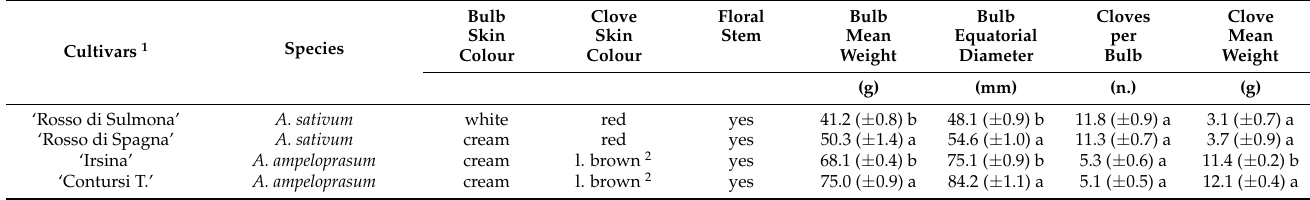
Table 1. Morphological traits of bulbs and cloves of garlic